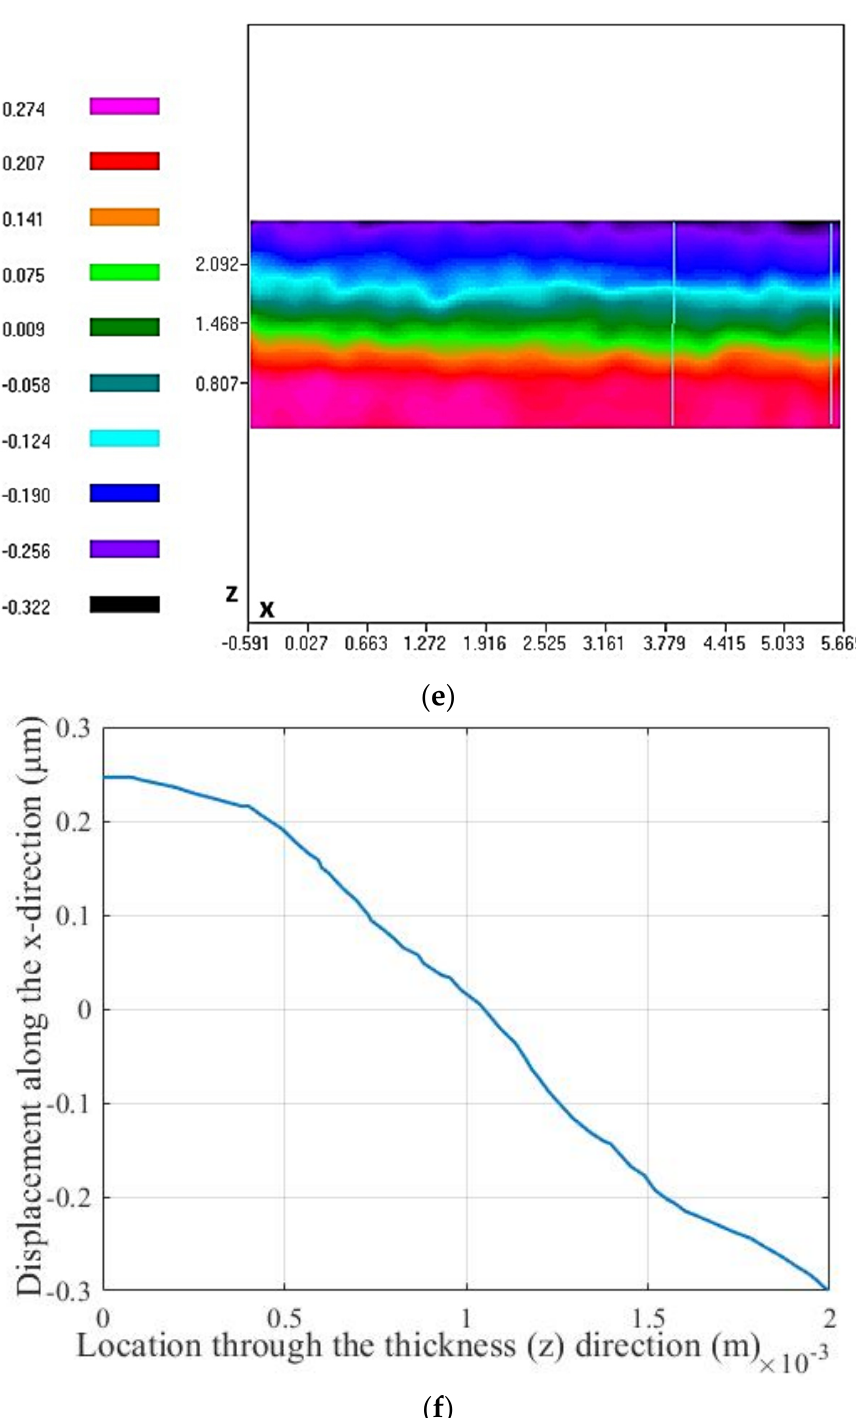
Figure 4. x -direction displacement distributions and their variation through the thickness at the end of the actuator produced by single actuator ( a , b ), two-stack actuator ( c , d ), and four-stack actuator ( e , f ) under an applied voltage of 199 V. The piezoelectric shear d 15 constant was extracted from measured length displace- ments using Equation (1) [21–23], and its values are presented in Table